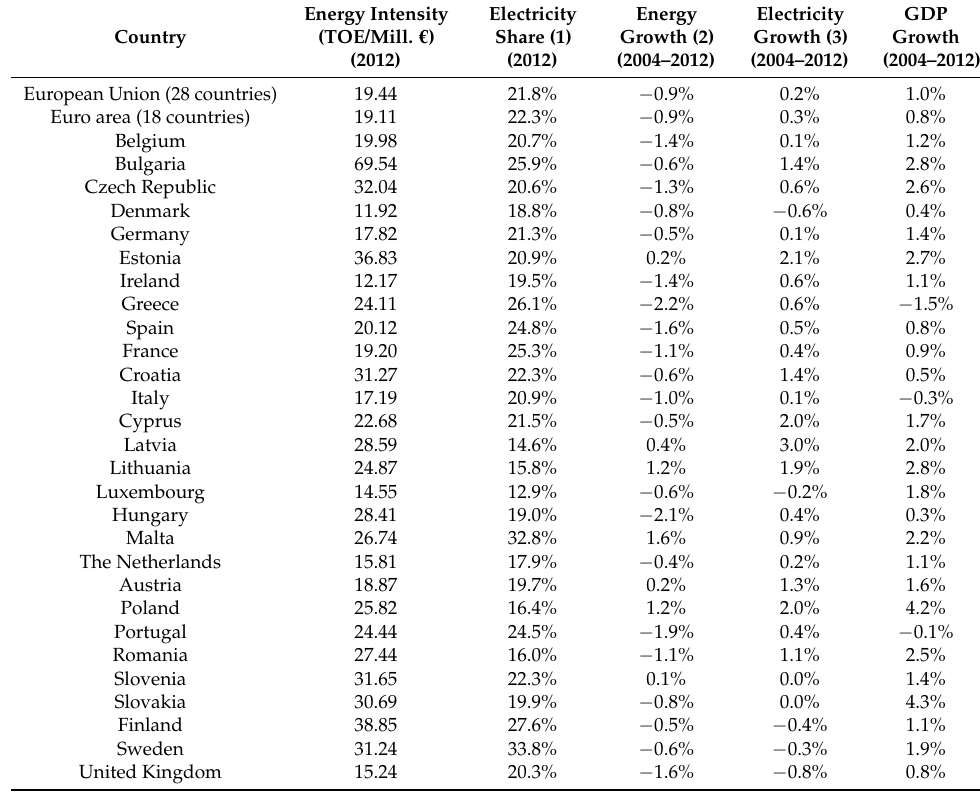
Table A1. Energy indicators in Europe.